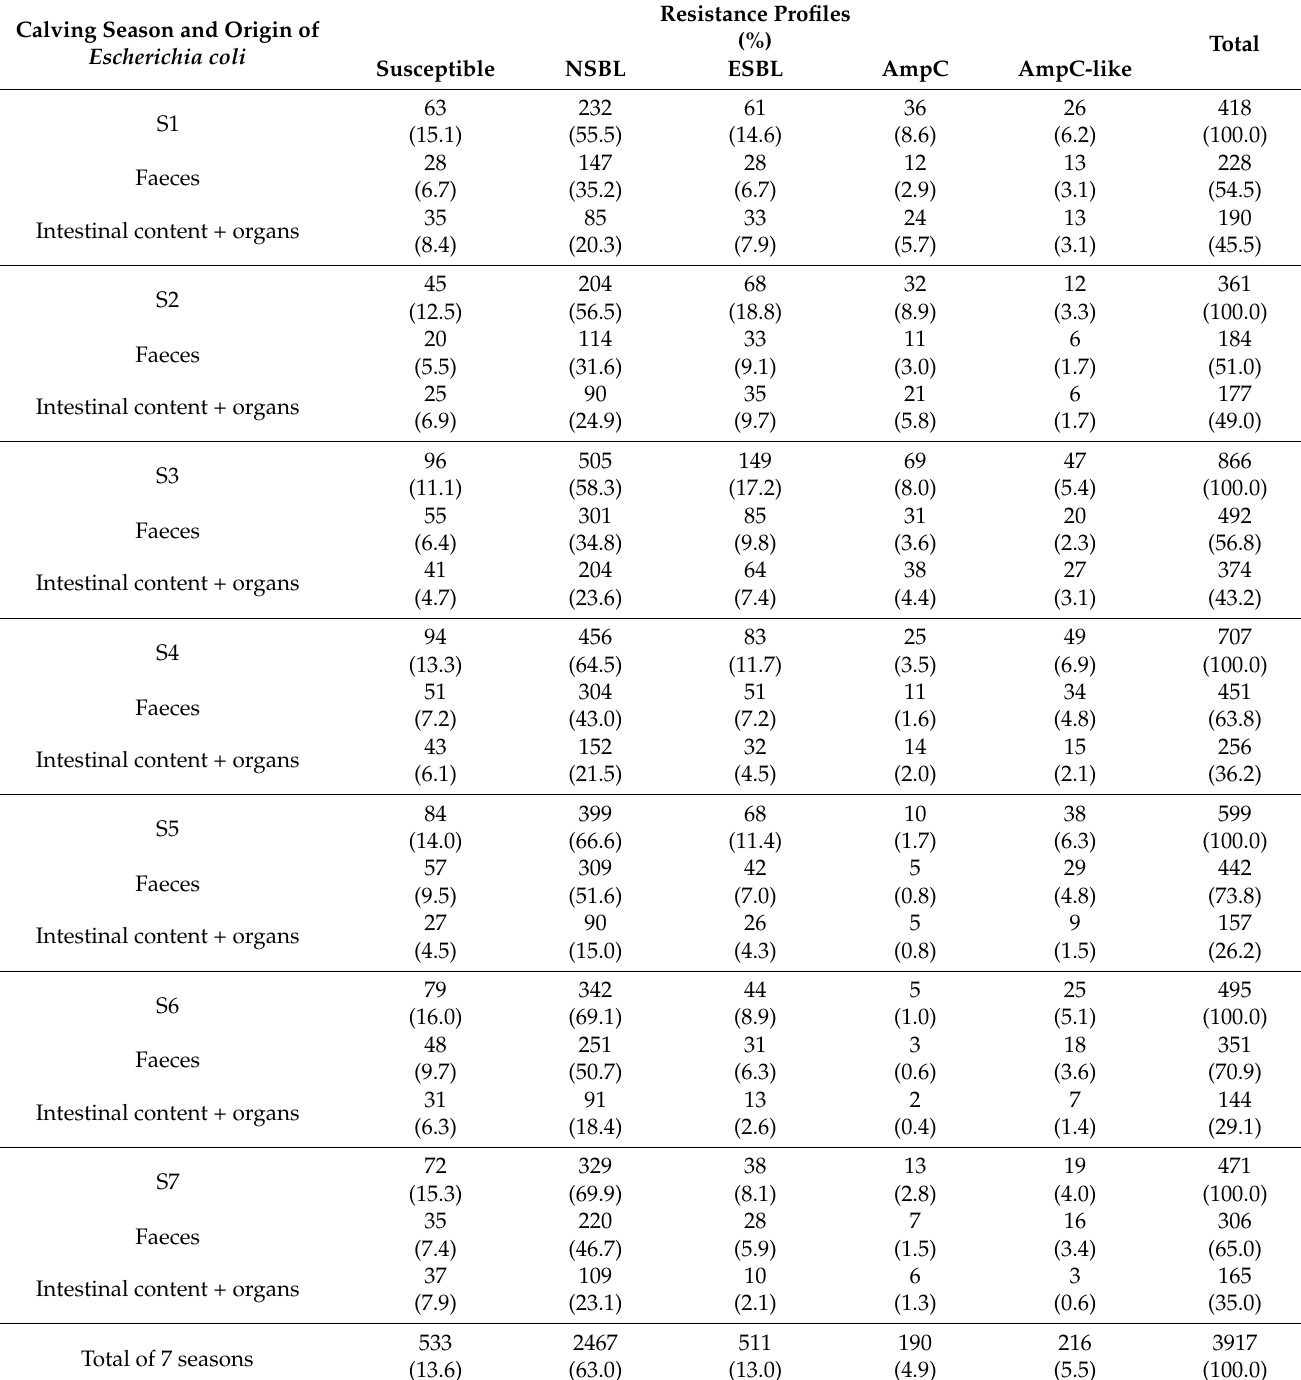
Table 2. Number and proportion of Escherichia coli isolates tested by disk diffusion assay for